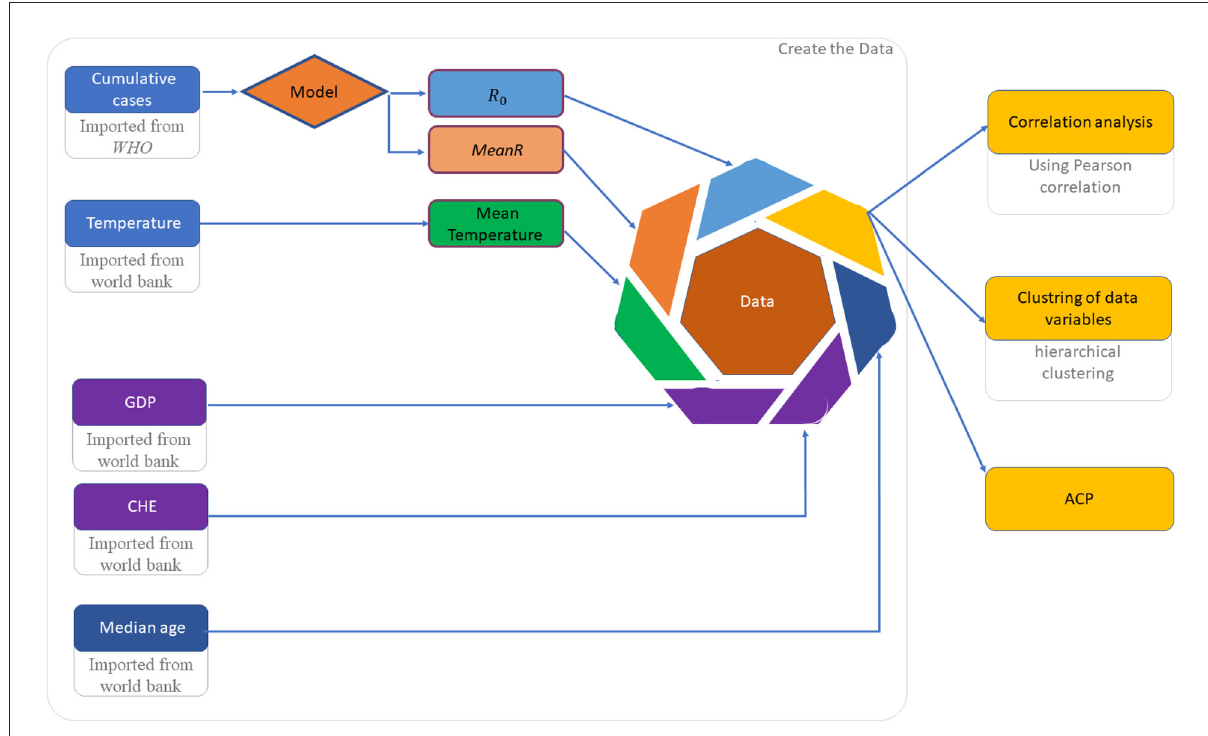
FIGURE2 Flowchart diagram to explain the different steps of the